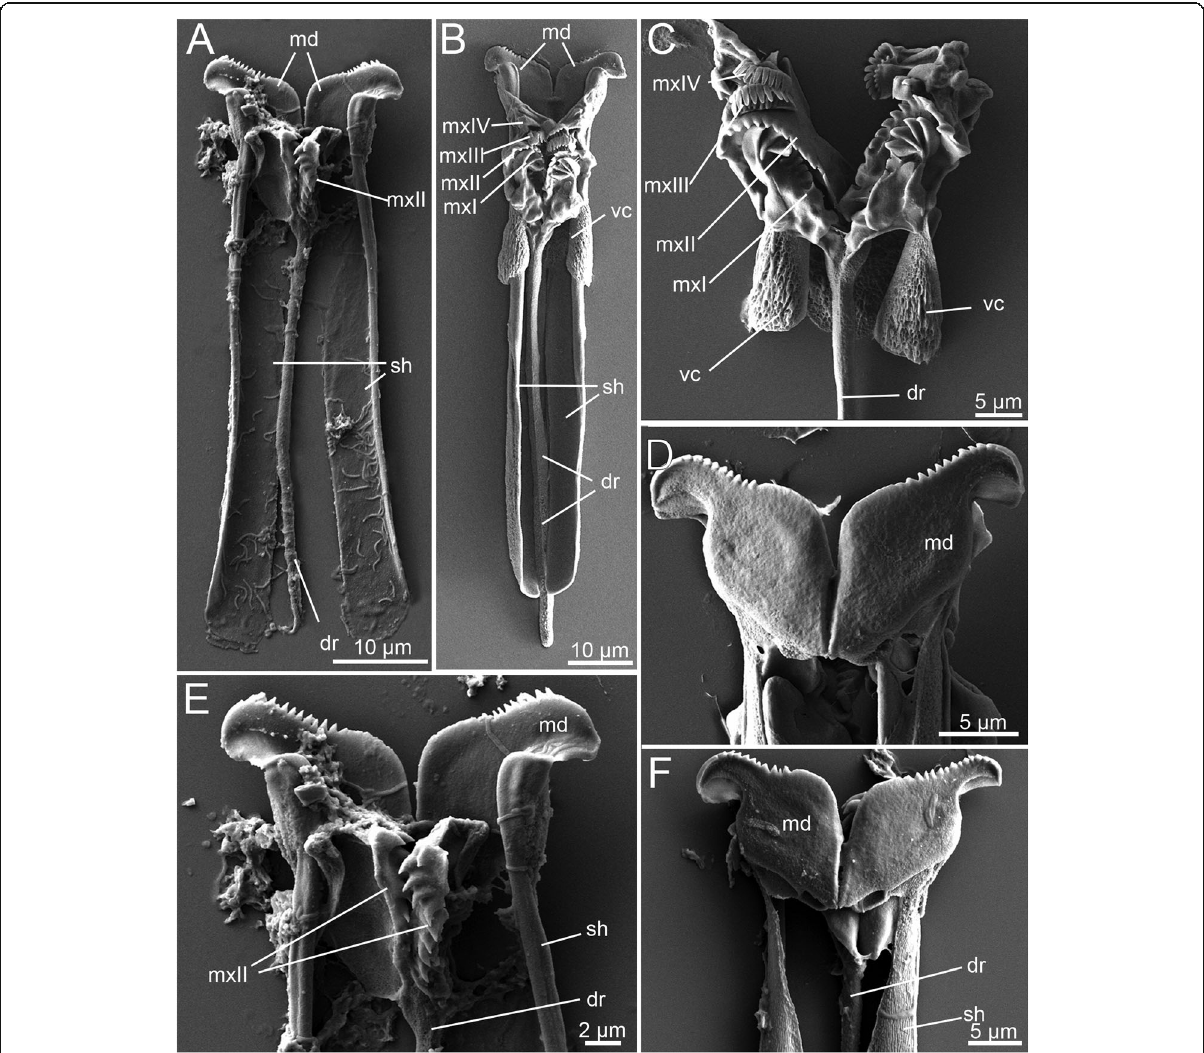
Fig. 7 General morphology of jaw components in Histriobdella homari . SEM images. All jaws are shown in dorsal view, except for (D) and (F), which are shown ventrally. a. Juvenile jaw apparatus with the main components. b. Adult jaw apparatus. c. Detailed view of the adult maxillae. d. Anterior end of the adult mandibles. e. Anterior part of the juvenile jaw apparatus. f. Anterior half of the juvenile jaw apparatus. dr, dorsal